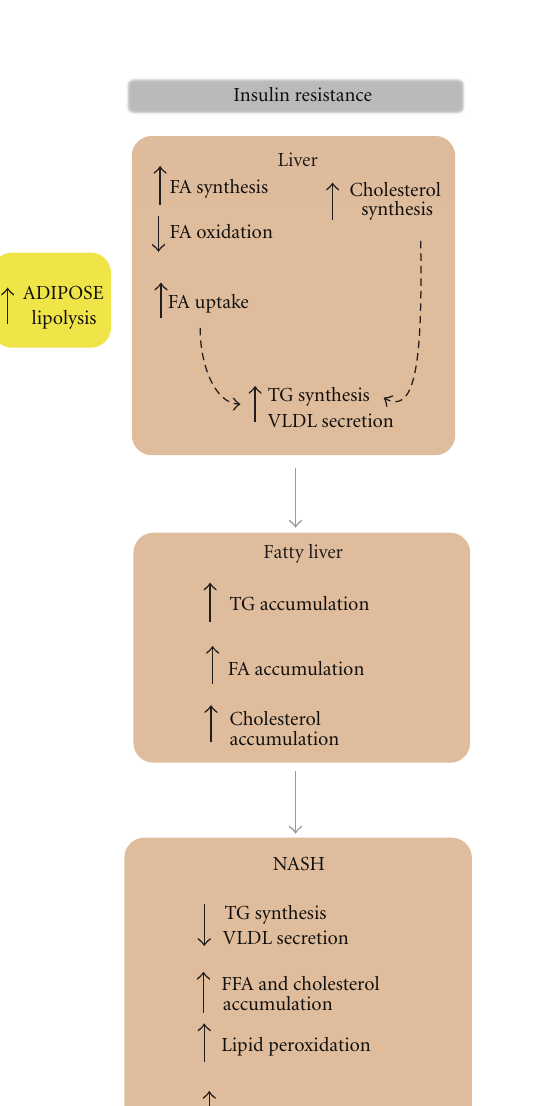
Figure 2: Summary of insulin resistance-induced lipid abnor- malities and consequent pathogenesis of NAFLD. In an insulin resistant setting, insulin is unable to inhibit lipolysis in adipose tissue leading to overflow of free FA into the bloodstream and in the liver. In the liver, hyperinsulinemia and hyperglycemia induce the synthesis of fatty acid and cholesterol which results in increased triglyceride synthesis and VLDL assembly and secretion. Since triglyceride synthesis prevails over VLDL secretion, excess triglycerides accumulate and lead to fatty liver development. In NASH, triglyceride synthesis and VLDL assembly is impaired and free FA and cholesterol accumulate. Increased lipid accumulation leads to lipid peroxidation and inflammation which exacerbates liver